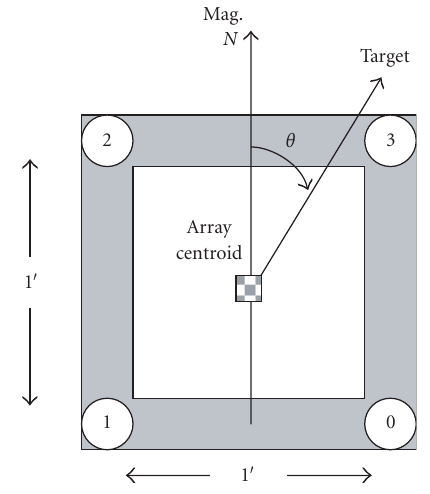
Figure 4: DOA sensor arrangement and angle